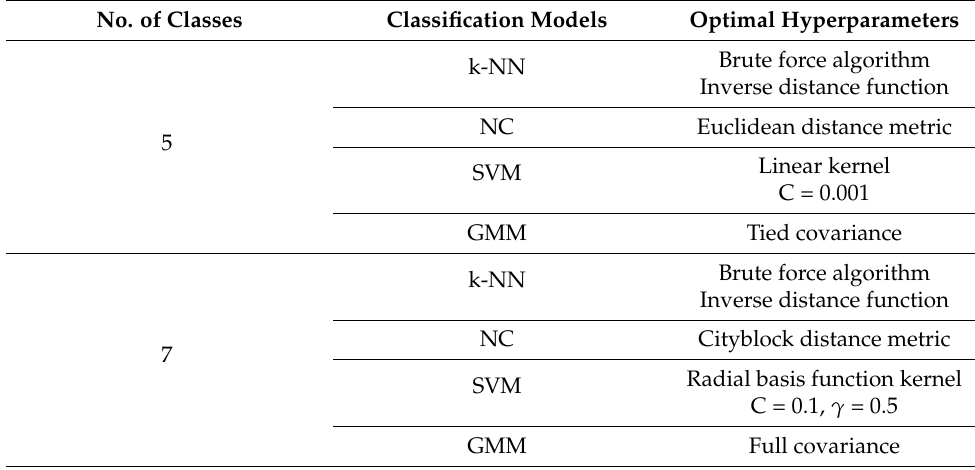
Table 5. Optimal parameters of each classification model type trained.